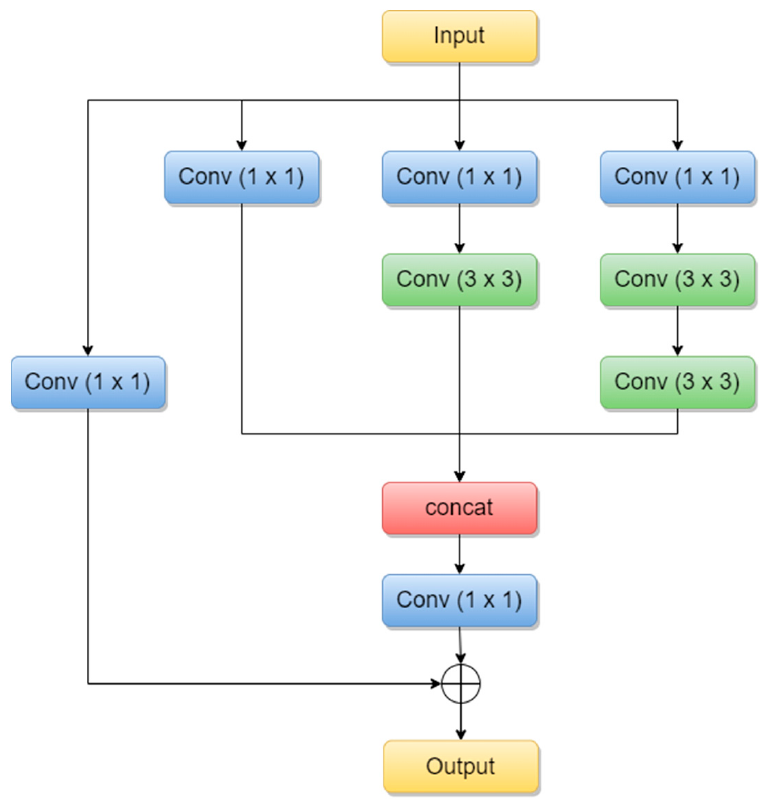
Figure 4. Residual-Inception block (adapted from [25]).